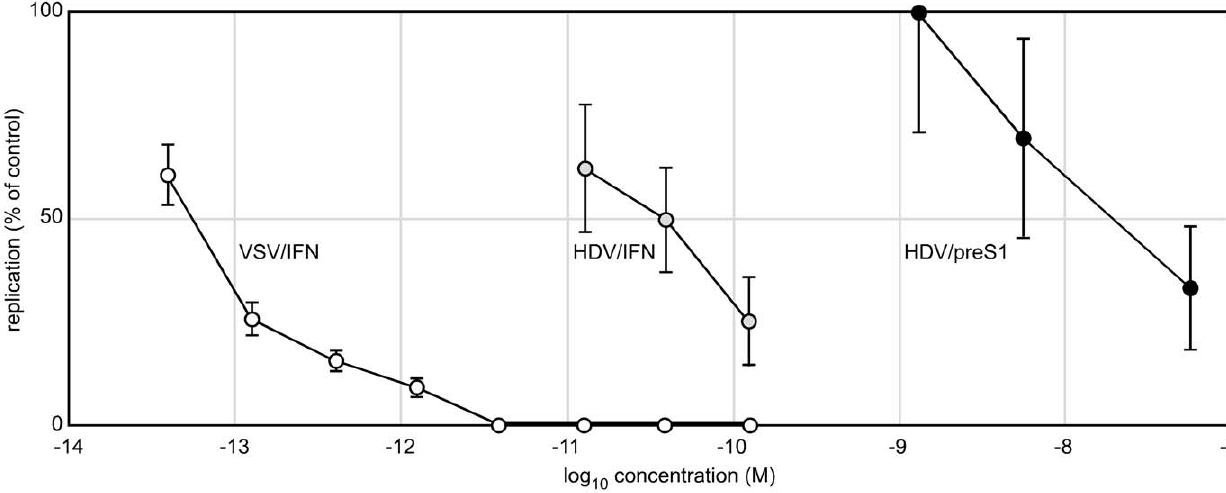
Figure 4. Dose response of HDV and VSV infections to interferon-alpha and preS1 peptide. For HDV infections the inhibitors were present from 24 h prior to infection and during the 16 h of exposure to virus. Replication was assayed at 6 days post-infection by realtime PCR, as in Fig. 1C. The assays were performed in triplicate, and average values are expressed as a percentage relative to the untreated controls, with the indicated standard error of the mean. For the VSV infections, the interferon was only present during the 16 h of virus exposure. VSV replication was assayed at 16 h by counting GFP positive cells. The values are expressed relative to untreated controls and the errors indicate the standard deviation as the square root of the mean. Interferon-alpha concentrations are expressed here as molarities, with 600 units/ml=0.12 nM. The preS1 peptide, like interferon-alpha, can inhibit HDV infection, but the needed molarity is 300-times more. Interferon-alpha can inhibit VSV infection but the concentration is 1,000-time less than that needed to inhibit HDV.